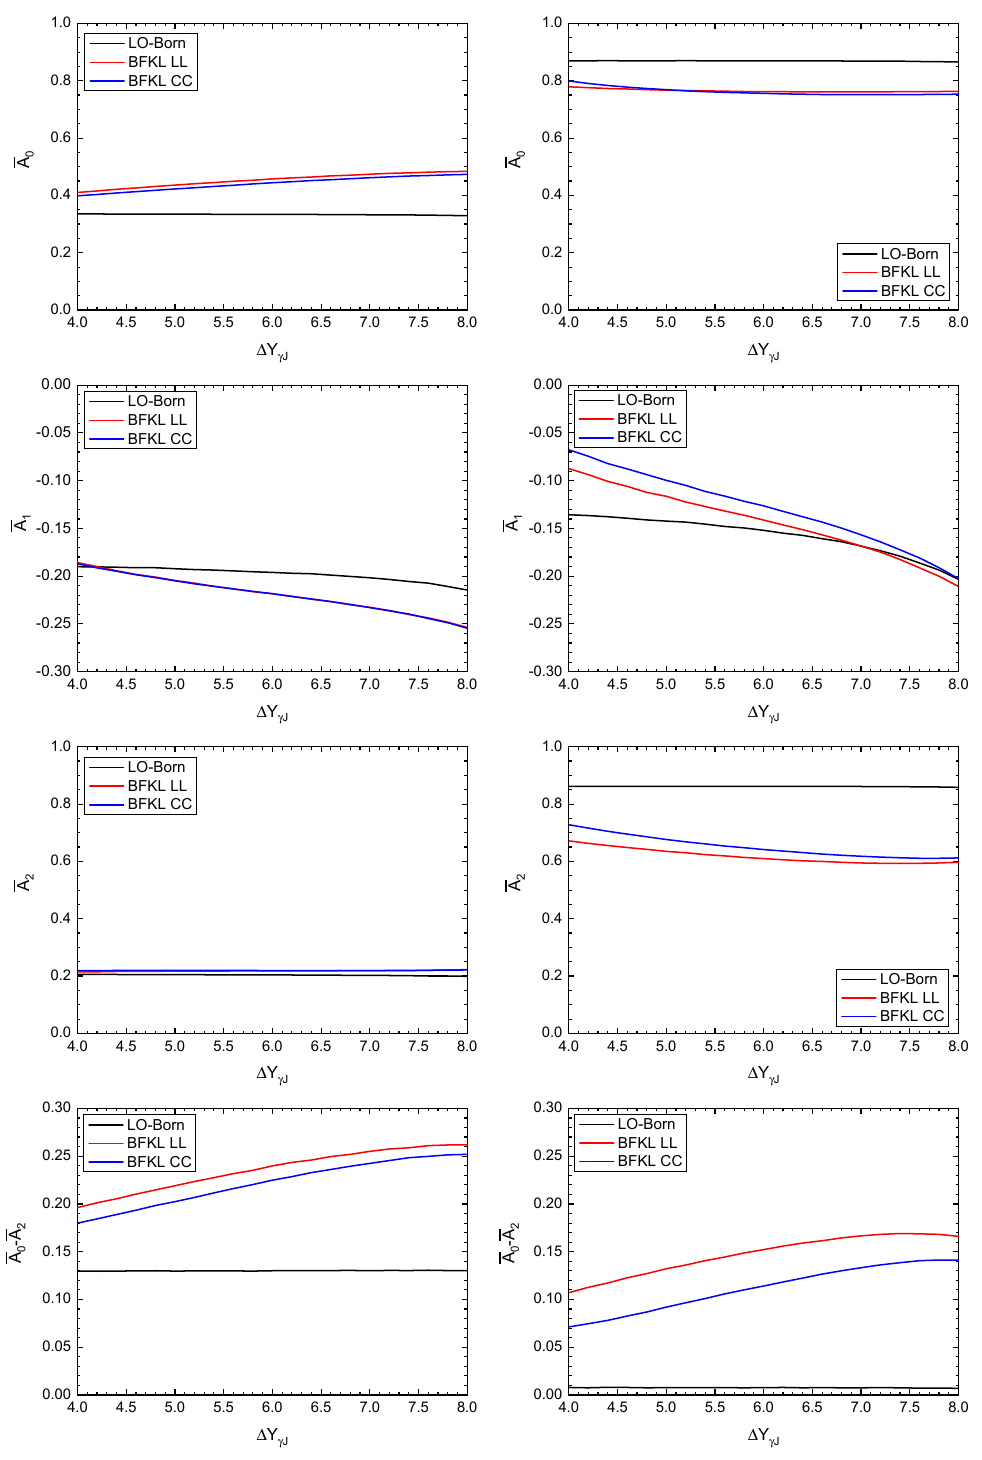
Figure 8 . The averaged over (cid:30) (cid:13)J coe(cid:14)cients (cid:22) A 0 ; (cid:22) A 1 and (cid:22) A 2 as functions of the photon-jet rapidity di(cid:11)erence (cid:1) Y (cid:13)J for the three indicated models together with the Lam-Tung di(cid:11)erence (cid:22) A 0 (cid:0) (cid:22) A 2 . The photon transverse momentum q ? = 25 GeV (left column) and q ? = 60 GeV (right column) while the other parameters: p J ? = 30 GeV, (cid:1) Y (cid:13)J = 7 and M = 35 GeV.